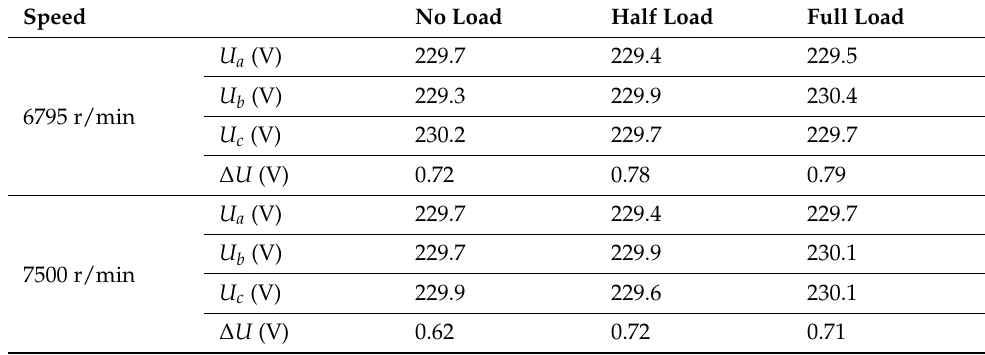
Table 6. Results of the steady-state performance